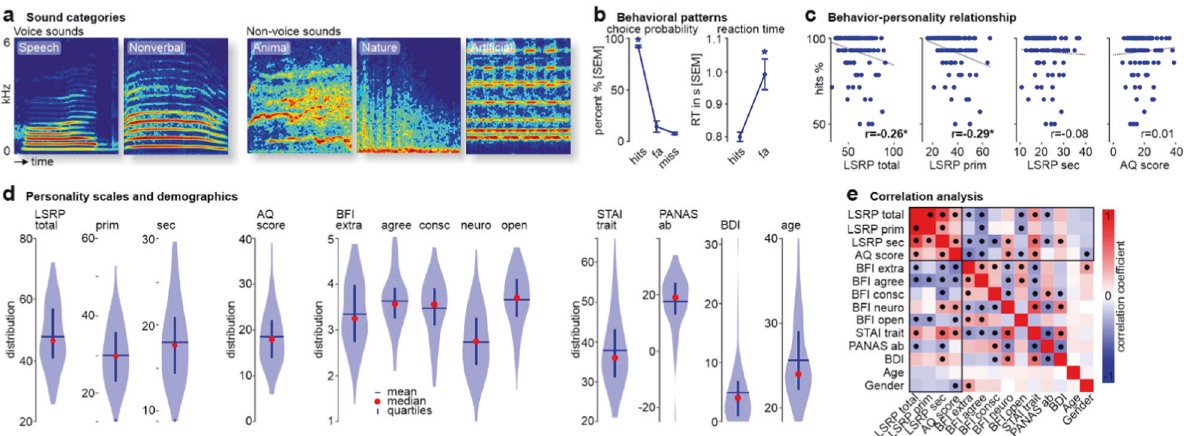
Fig. 1 Experimental sounds, behavioral performance, and personality traits. a Spectrograms of example sounds from the fi ve sound categories, namely voice (speech, nonverbal) and non-voice sounds (animal, nature, arti fi cial). b Choice probability and reaction times for the sound repetition task separately for hit trials (correct detection of repetitions), false alarms (fa, incorrect classi fi cation of non-repetition trials as a repetition), and missed trials (miss, missed detection of repetition trials); * p < 0.05 (Bonferroni corrected). c Correlation of detection probability for hit trials and psychopathic (LSRP total score, LSRP primary score [prim], LSRP secondary score [sec]) and autistic traits (AQ score); * p < 0.05 (FDR corrected). d Distribution of scores for personality traits (LSRP, AQ, BFI, STAI, PANAS, BDI) and demographic features (age). e Correlation matrix (mirror symmetric) between personality traits and demographic scores (age, gender); ● p < 0.005 (FDR corrected). AQ Autism Spectrum Quotient, BDI Beck Depression Inventory, BFI Big Five Inventory (extra extraversion, agree agreeableness, consc conscientiousness, neuro neuroticism, open openness), LSRP Levenson Self-Report Psychopathy scale, PANAS Positive and Negative Affect Schedule (ab affective balance), STAI State Trait Anxiety